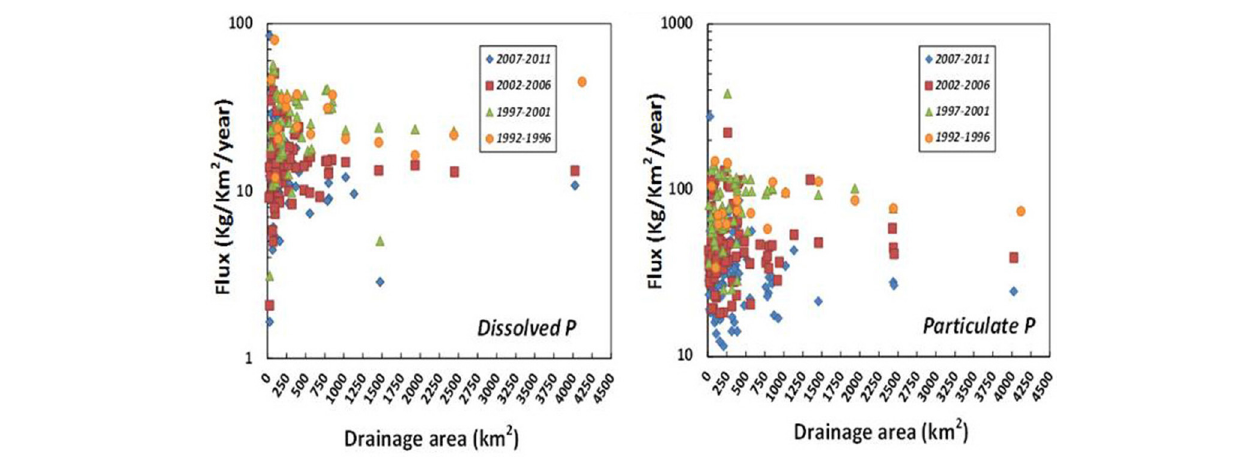
FIGURE 1 | The relationship between dissolved an particulate P fluxes and drainage areas as observed in Brittany rivers, Western France. Fluxes have been calculated as average values for periods of four consecutive years, in order to minimize flux uncertainities. The two plots data from 117 monitoring station. Drainage areas ranges from 11 to 4,000 km 2 . For both dissolved and particulate P fluxes, an increase variability is observed when moving from large rivers toward headwater catchments, the maximum of variability occurring for headwater catchments of drainage area < 50 km 2 (Legeay et al., 2015).